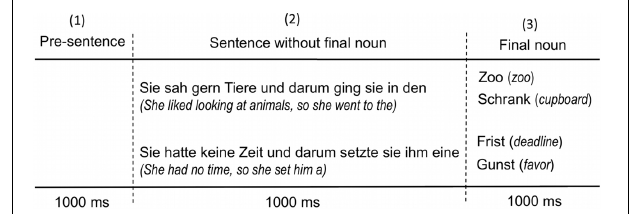
FIGURE 1 | Scheme of the electrode montage, the reference used (R) and the subdivision into three main domains (anterior, posterior, anterior-posterior) for long-range coherence analysis (gray areas). Electrodes used for statistical analyses are mapped on the scheme.